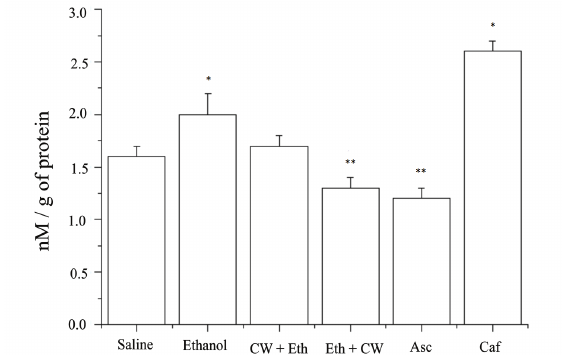
Figure 4 - Eff ect of CW, ascorbic and caff eic acid in the liver lipid peroxidation of rats treated by ethanol. Eth – 2.5 mL/ followed by 2.5 mL/Kg ethanol; Eth+CW – 2.5 mL/Kg